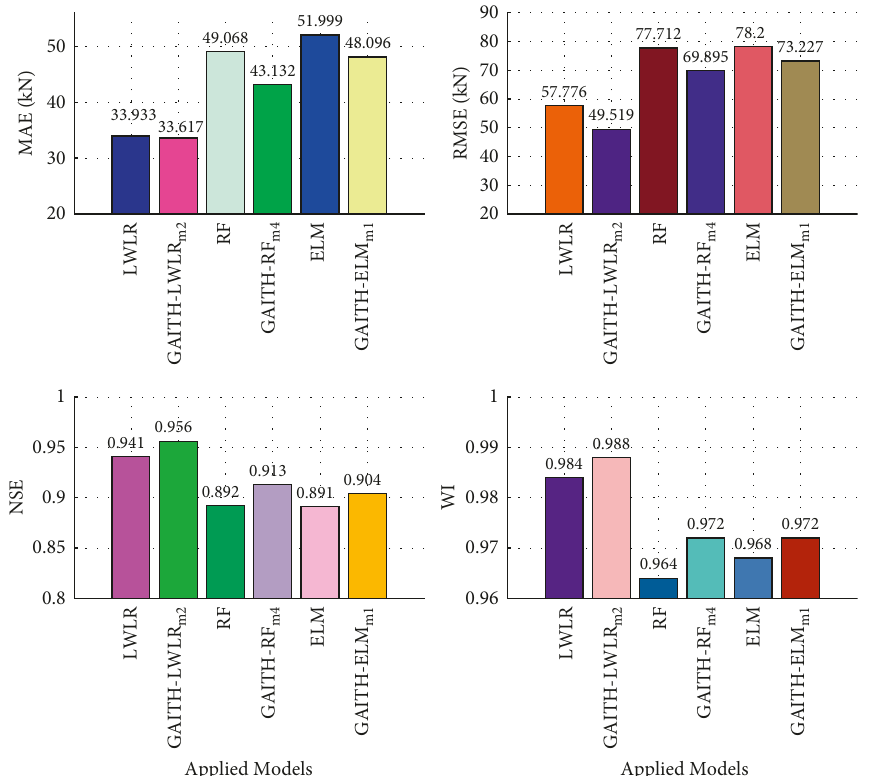
Figure 13: Comparison between the proposed models before and after using feature selection algorithm: testing phase.